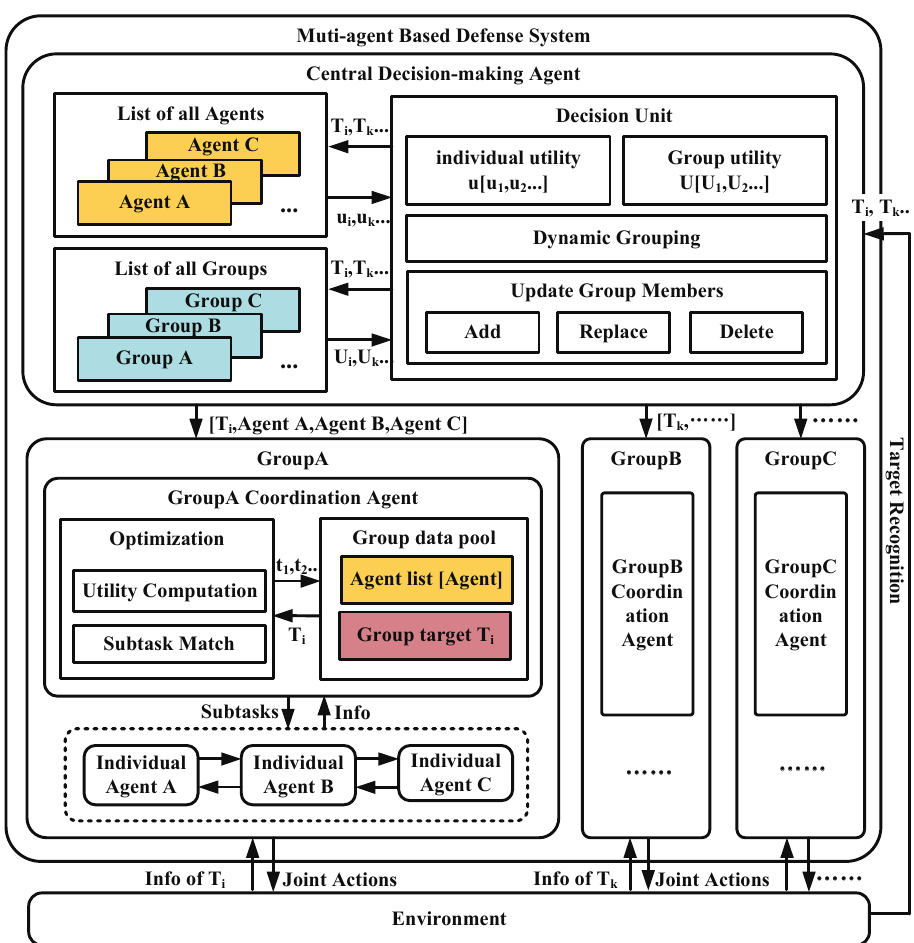
Figure 4. The multi-agent-based defense system design and data